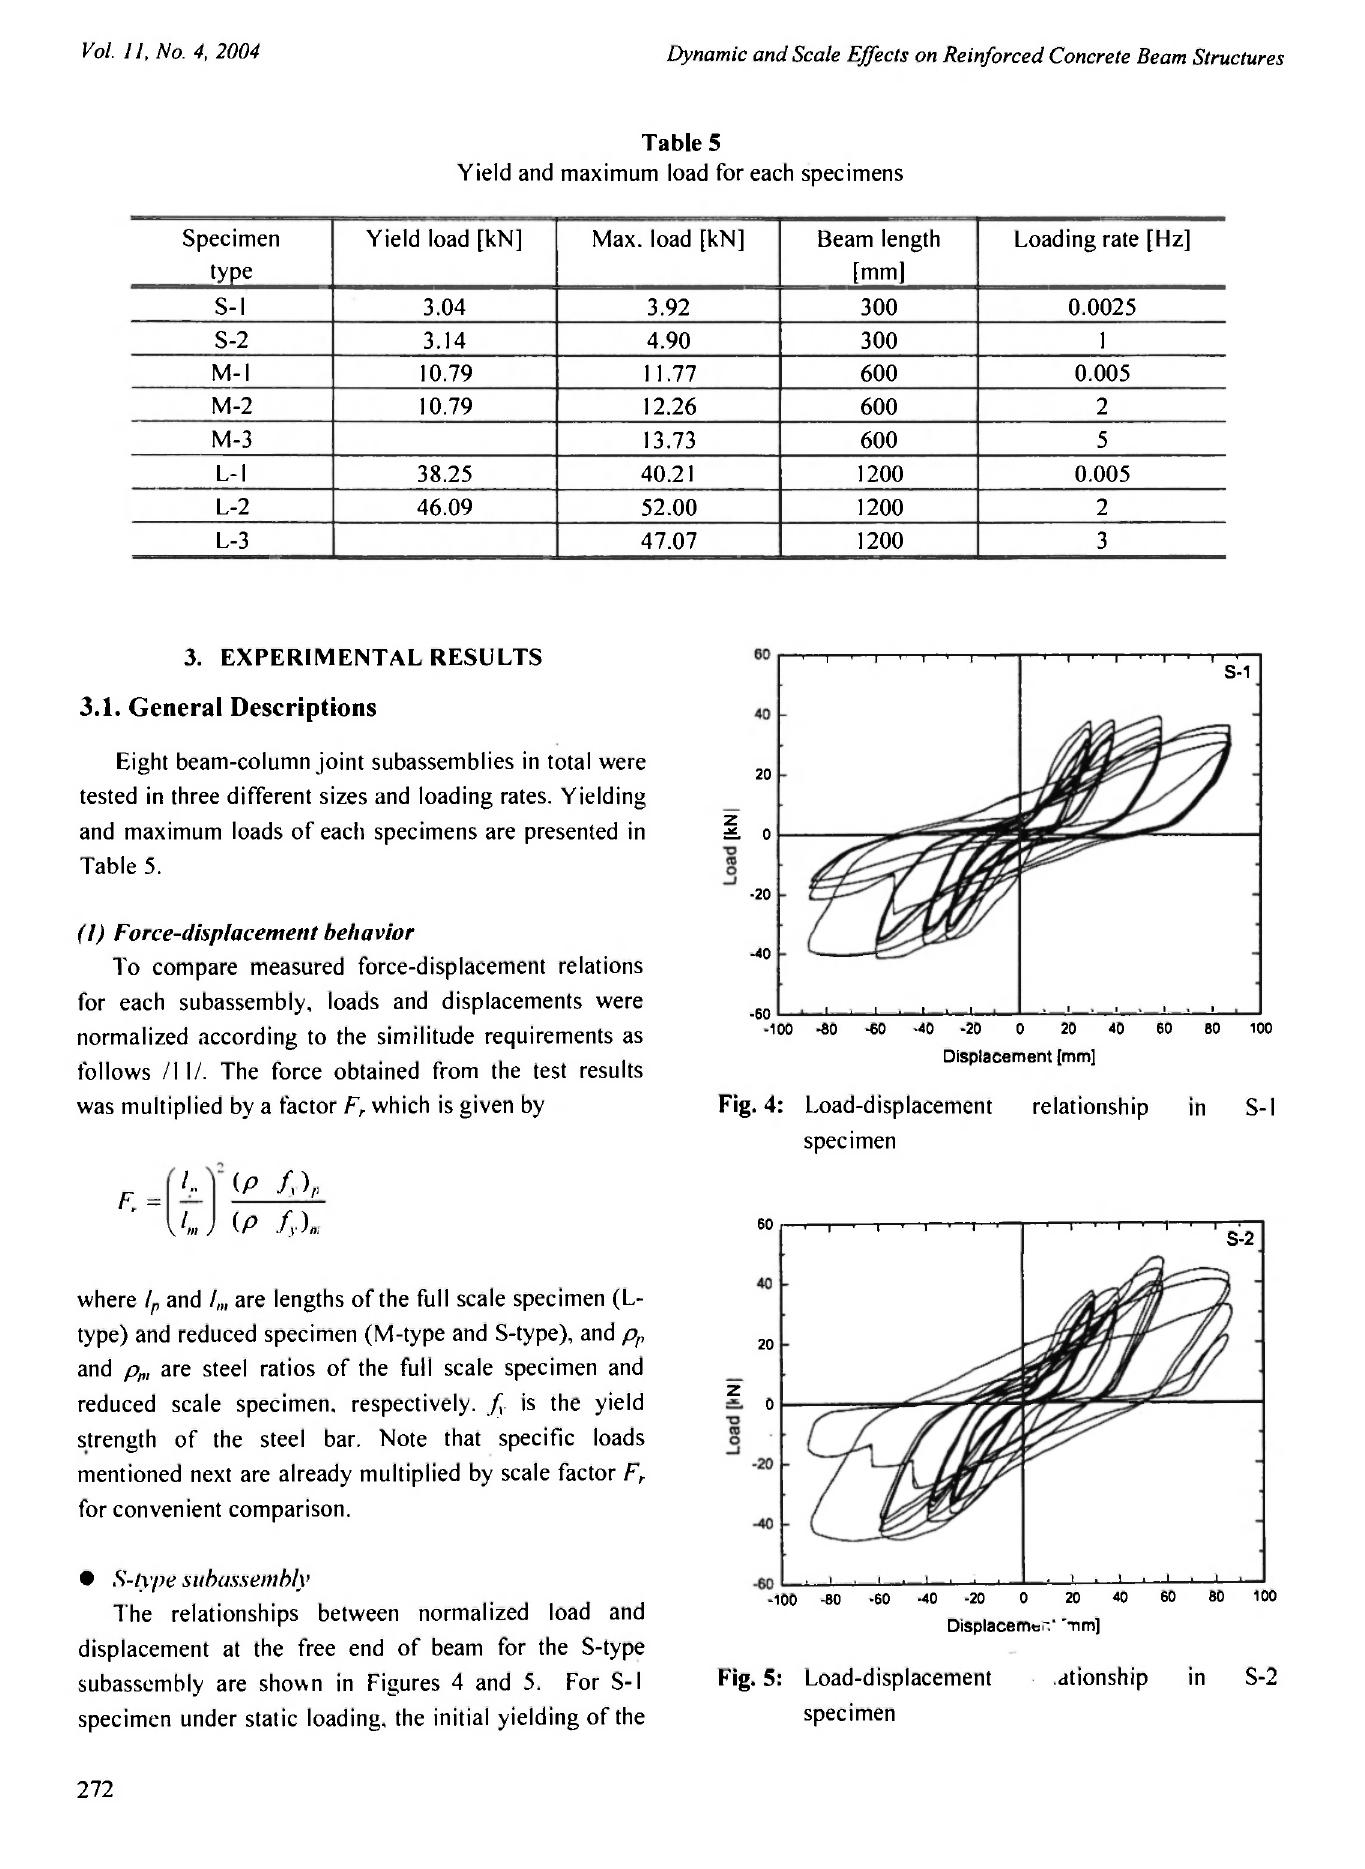
Fig. 4: Load-displacement